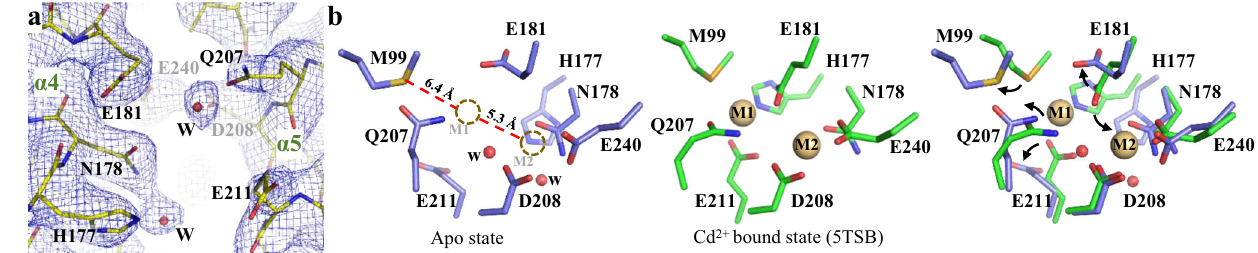
Fig.2|StructureoftheBMCofBbZIPintheapostate.a Electrondensitymapof the BMC (transport sites) of BbZIP in the apo state. The 2FoFc map ( σ =1.2) is depicted as blue meshes. b Structural comparison of the BMC in the apo state and the substrate bound state. In the apo state structure, the M1 and M2 sites are markedbydashedcircles,andthedistancesbetweentheM1siteandtwochelating